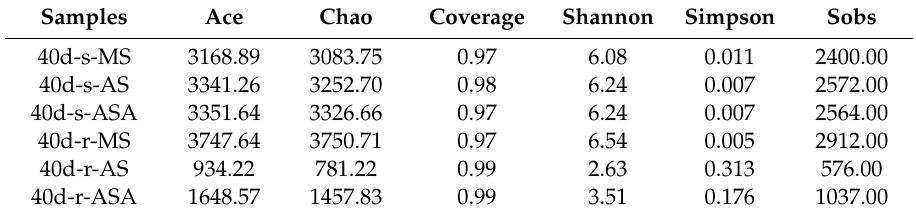
Table 1. Summary of the indices of community richness and diversity of bacterial taxa in MS, AS and ASA groups.